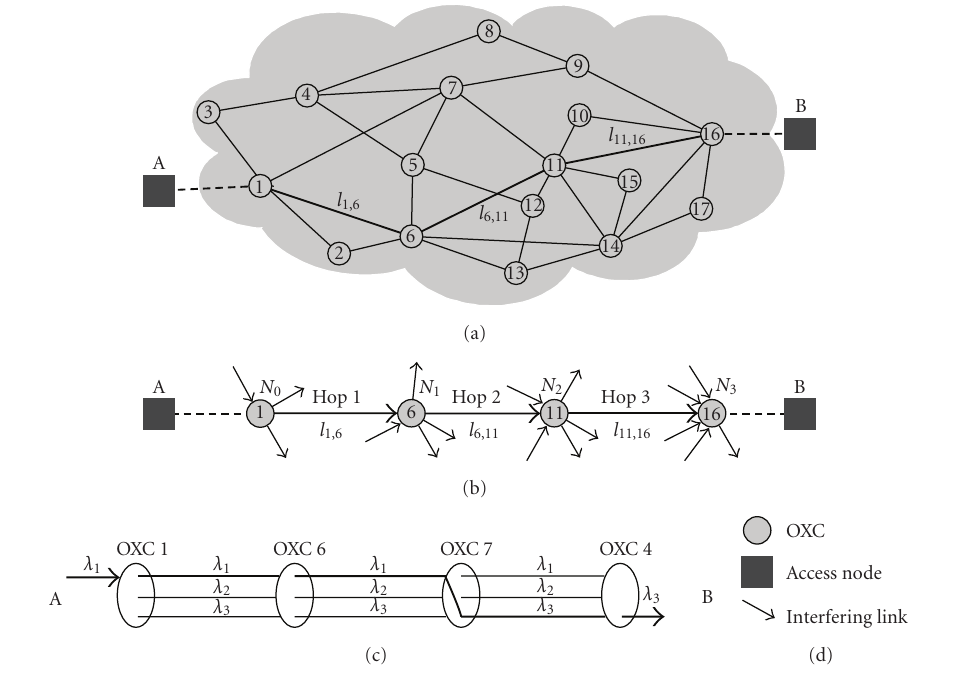
Figure 1: WDM network. (a) The model of a single-fiber WDM network ( F = 1). (b) The physical network path between nodes A, B consists of 3 hops and 4 nodes ( N = 4, H = 3). The network is modeled as a directed graph. (c) The optical domain consists of 3 wavelengths ( λ 1 , λ 2 , and λ 3 ) on each link ( W = 3). Table 1: The blocking probability model for uniform link